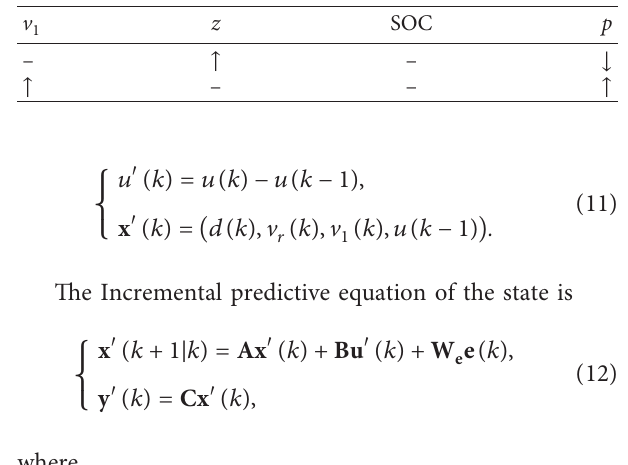
Table 3: Basic rules of regenerative braking.